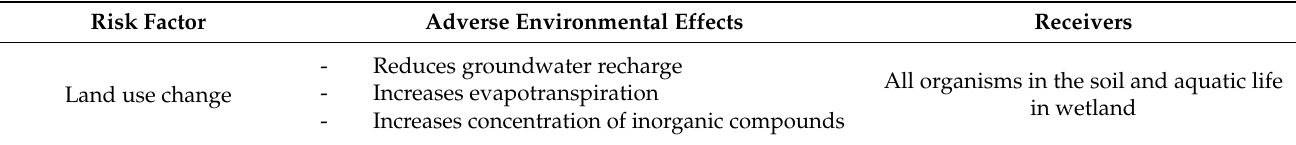
Table 1. Characteristics of the risk factors in